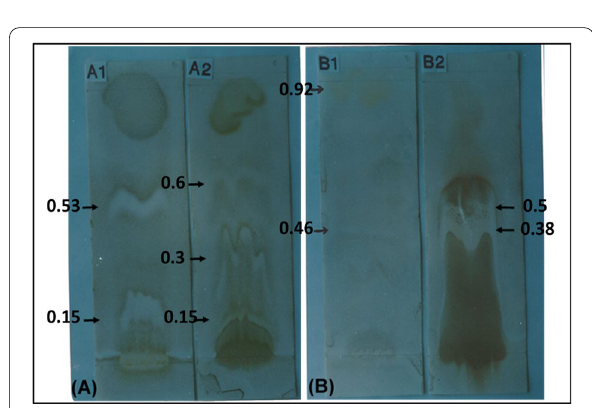
Fig. 1 Antifungal evaluation of various plant extracts against dermatophytes. *Mean of three replica plates; P < 0.05. ***Concentration of reference antibiotic (MIC) was 0.6 µg ml − 1 for M. gypseum ; 0.8 µg ml − 1 for M. nanum ; 2.5 µg ml − 1 for T. mentagrophytes ; and 0.6 µg ml − 1 for T. terrestre